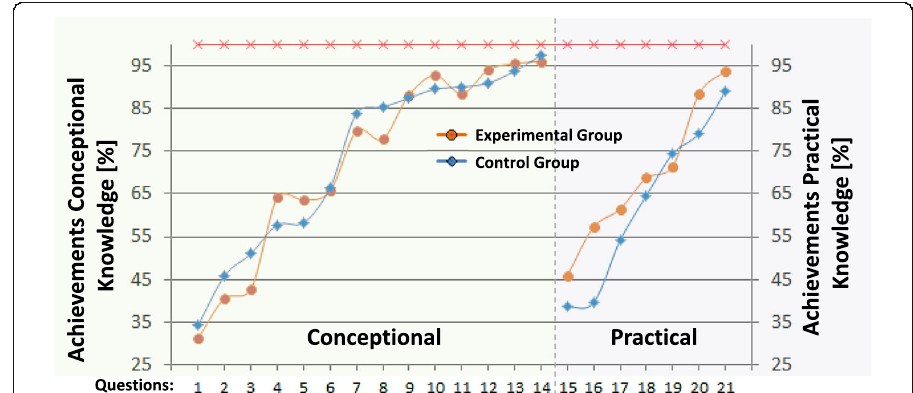
Fig. 9 Effect of CPR on exam results as Variable 7. Not significant (p > .05) over all questions, horizontal line shows theoretical